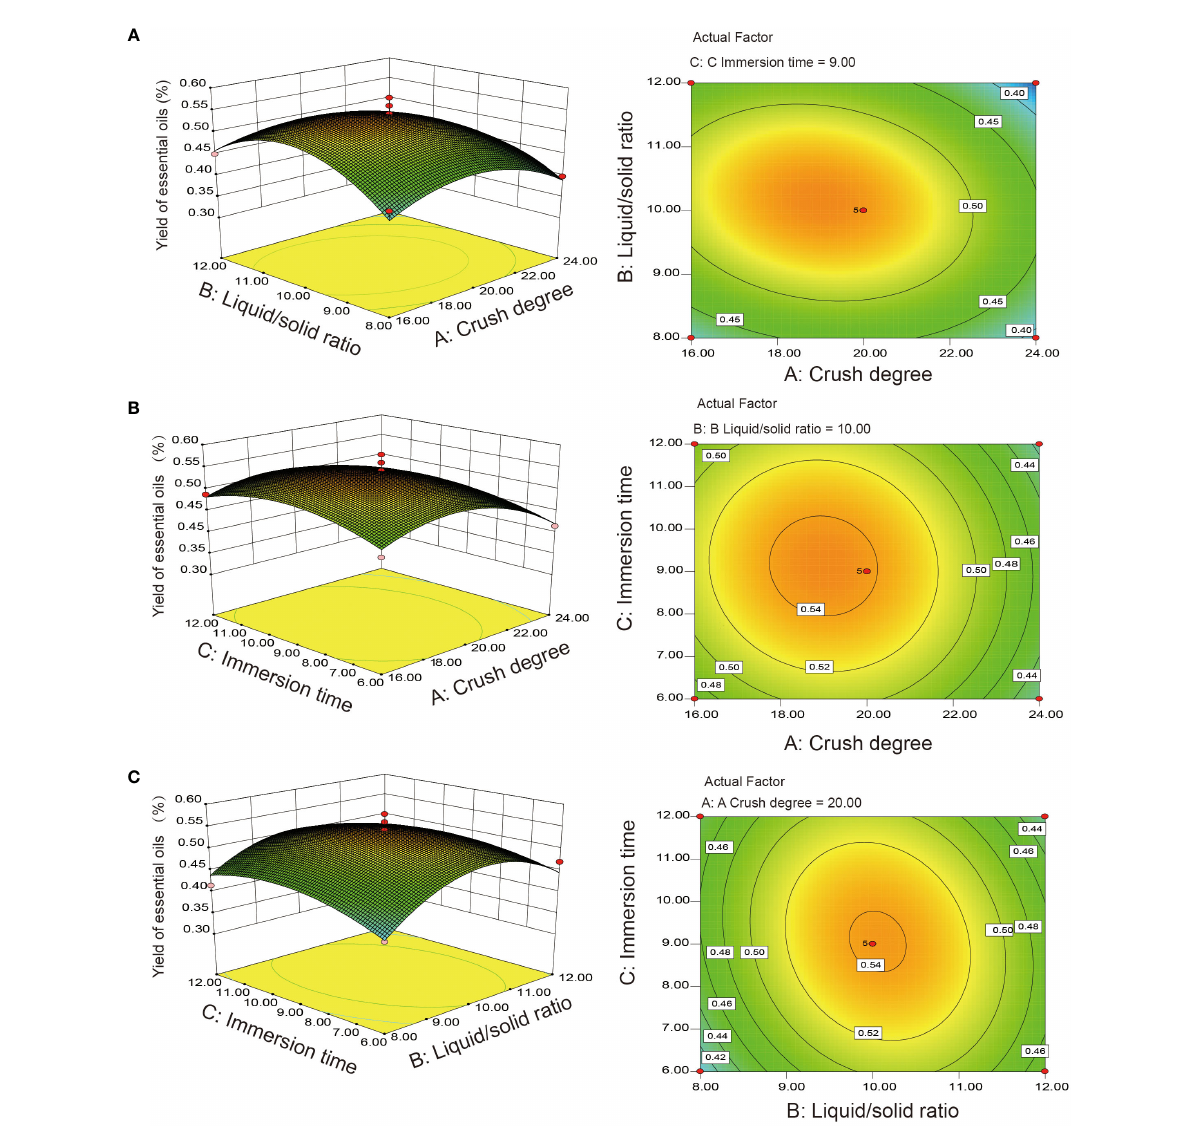
FIGURE 1 Response surface plots and contour map for the interaction analyzes. (A) Crush degree and liquid – solid ratio; (B) Crush degree and immersion time; (C) Liquid – solid ratio and immersion